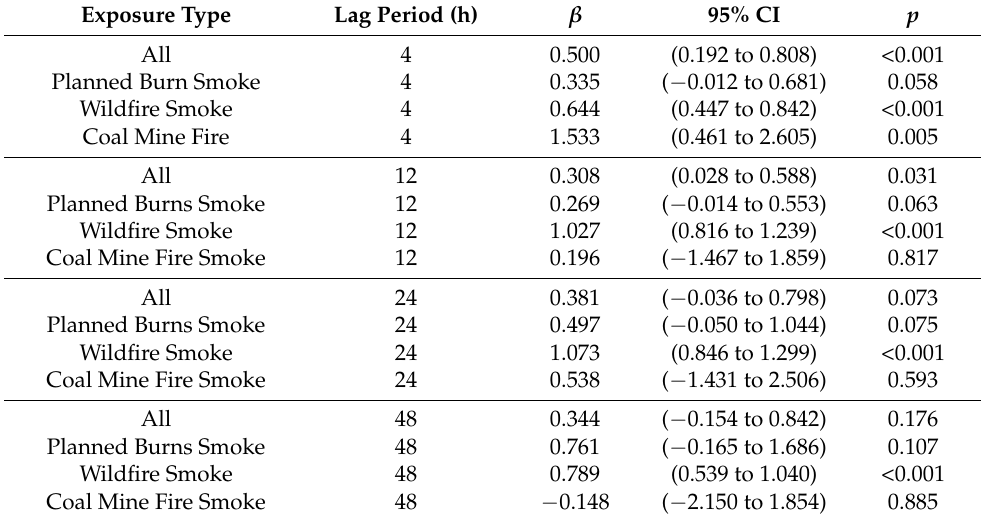
Table 3. Changes in fractional exhaled nitric oxide (FeNO) (ppb) Regression coefficients ( β ) and 95% confidence intervals per 10 µ g/m 3 PM 2.5 adjusted for temperature, humidity, smoking status, asthma diagnosis and age.